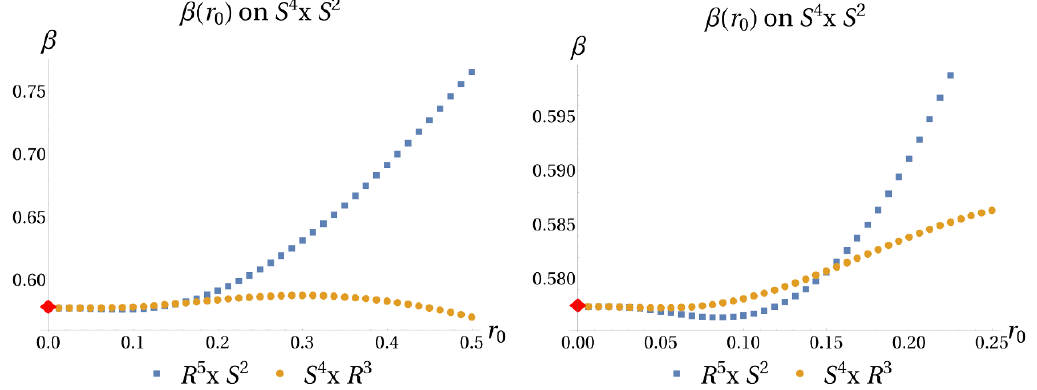
Figure 11 . The ratio of radii (cid:12) as a function of the closing radius r 0 for both topologies with conformal boundary S 4 (cid:2) S 2 . The red diamond is the analytical calculation for the singular ratio (cid:12) s .